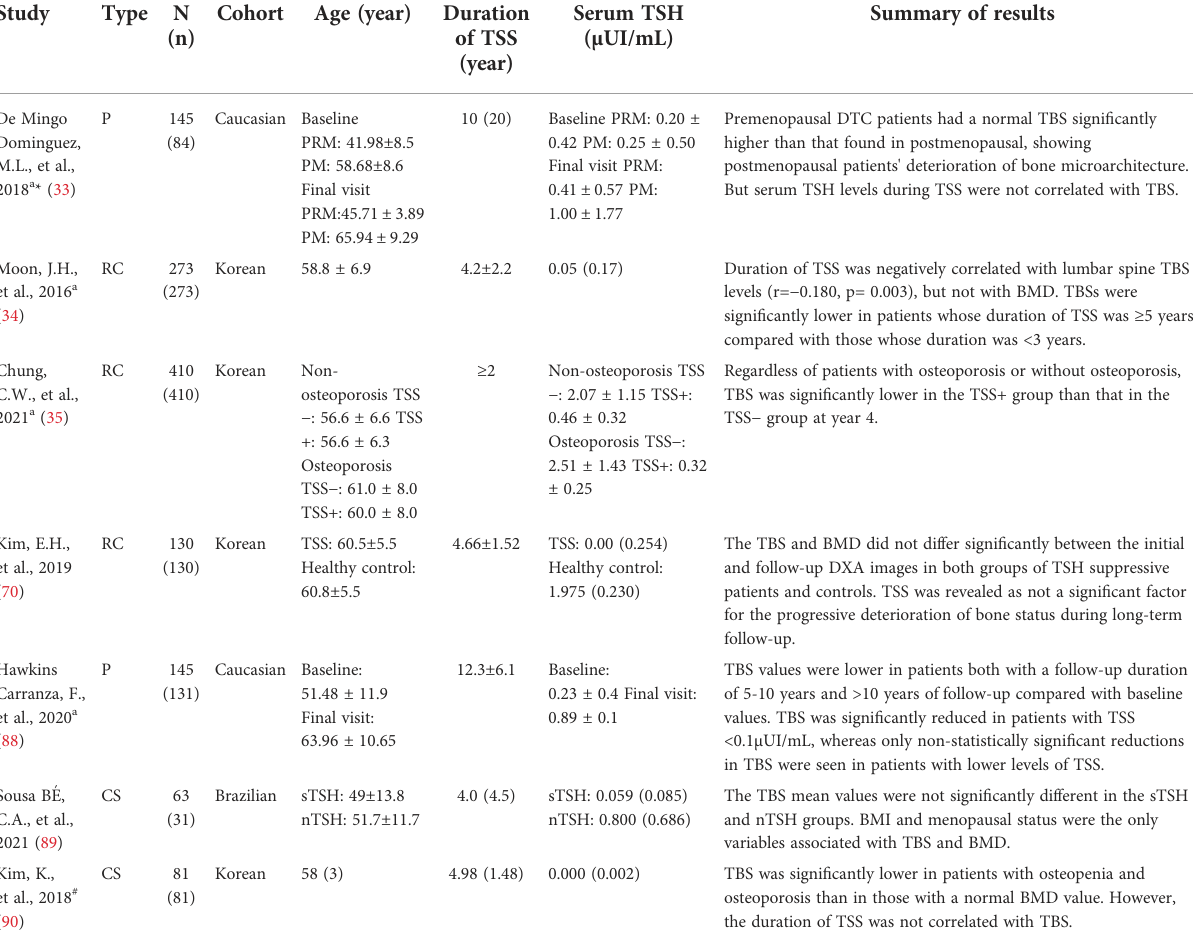
TABLE 1 Characteristics of the cohorts included in the